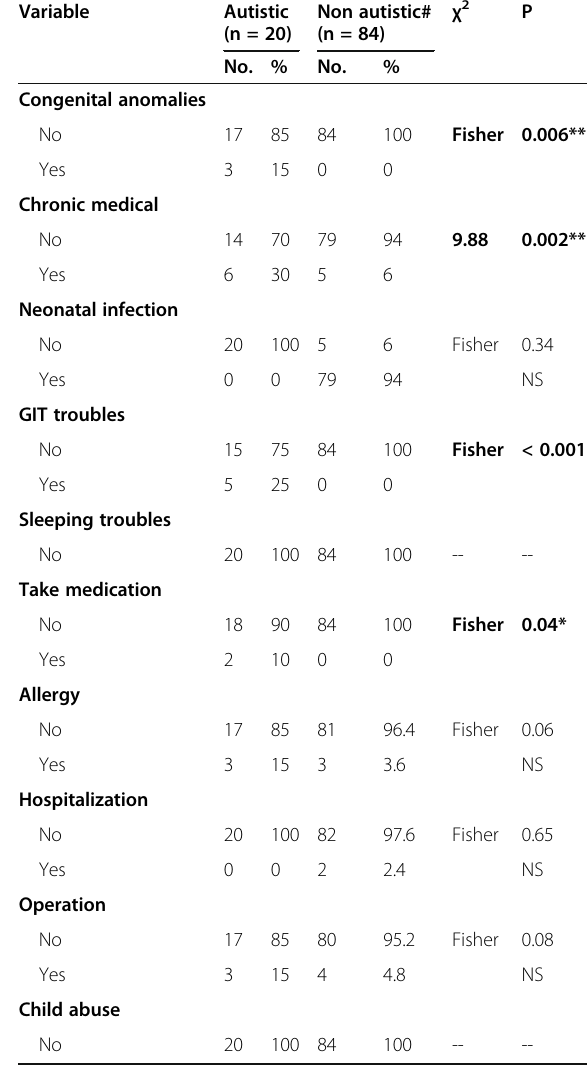
Table 4 Comparison between autistic and non-autistic children in child medical